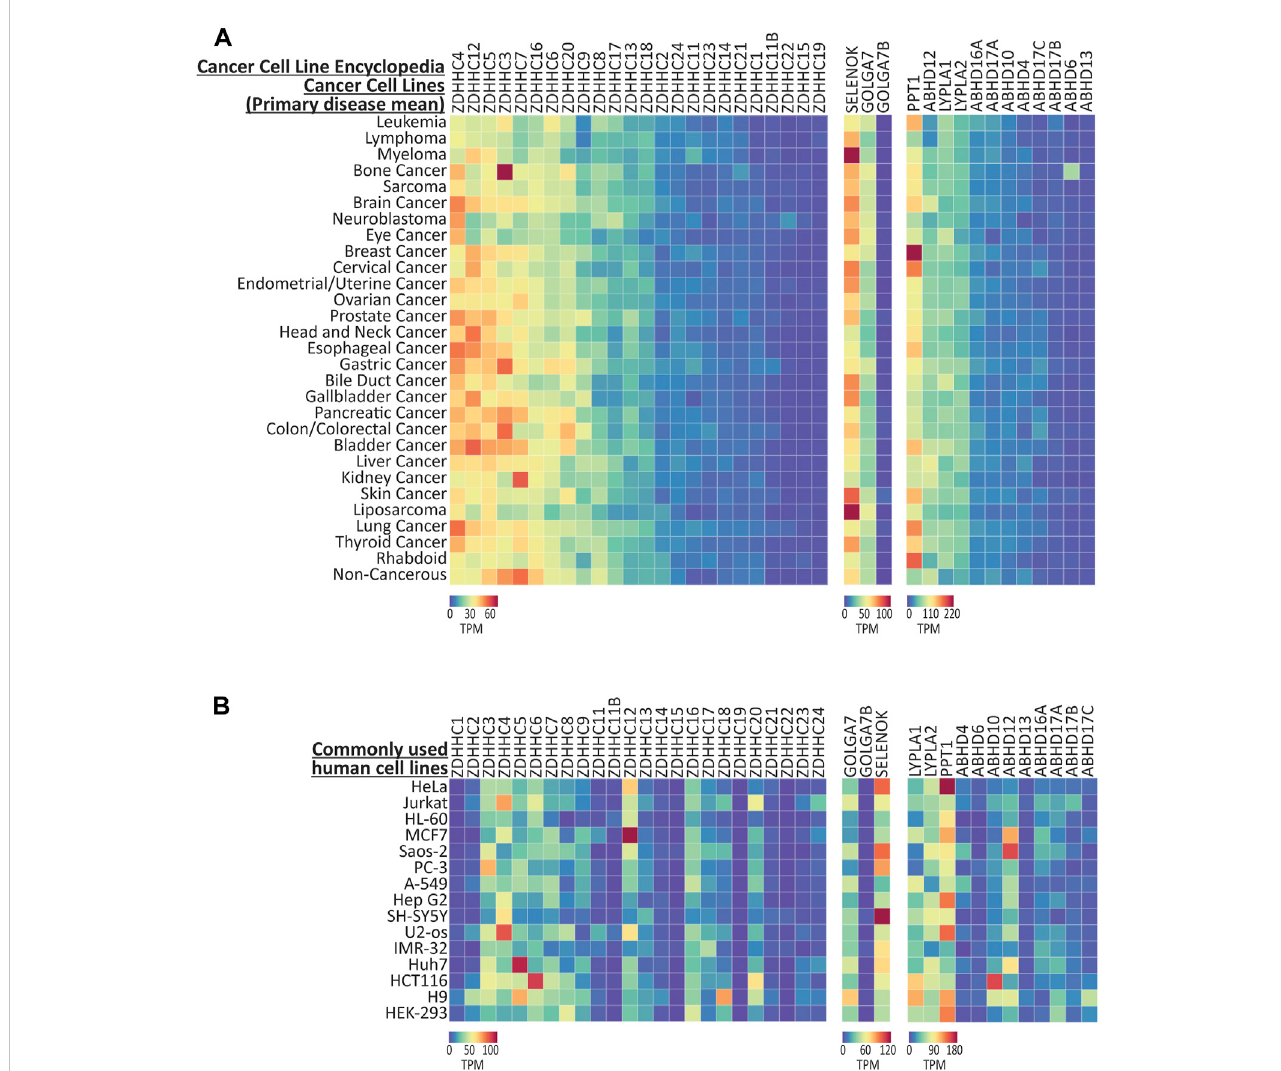
FIGURE 3 Expression of the genes that regulate palmitoylation from CCLE cancer cell lines. (A) Heatmap showing RNAseq expression data for the genes that regulate S -palmitoylation, downloaded from CCLE and averaged according to ‘ Primary Disease ’ . Data are included from 1406 cell lines, averaged into 30 primary disease types. (B) Expression data for selected human cell lines that are commonly used for basic research. All data were extracted from the CCLE dataset, except the H9 cell line which was found only in the CMP dataset, and HEK-293 that was found in the HPA cell line dataset. Heatmap units: Transcripts per million (TPM). All data available for download on